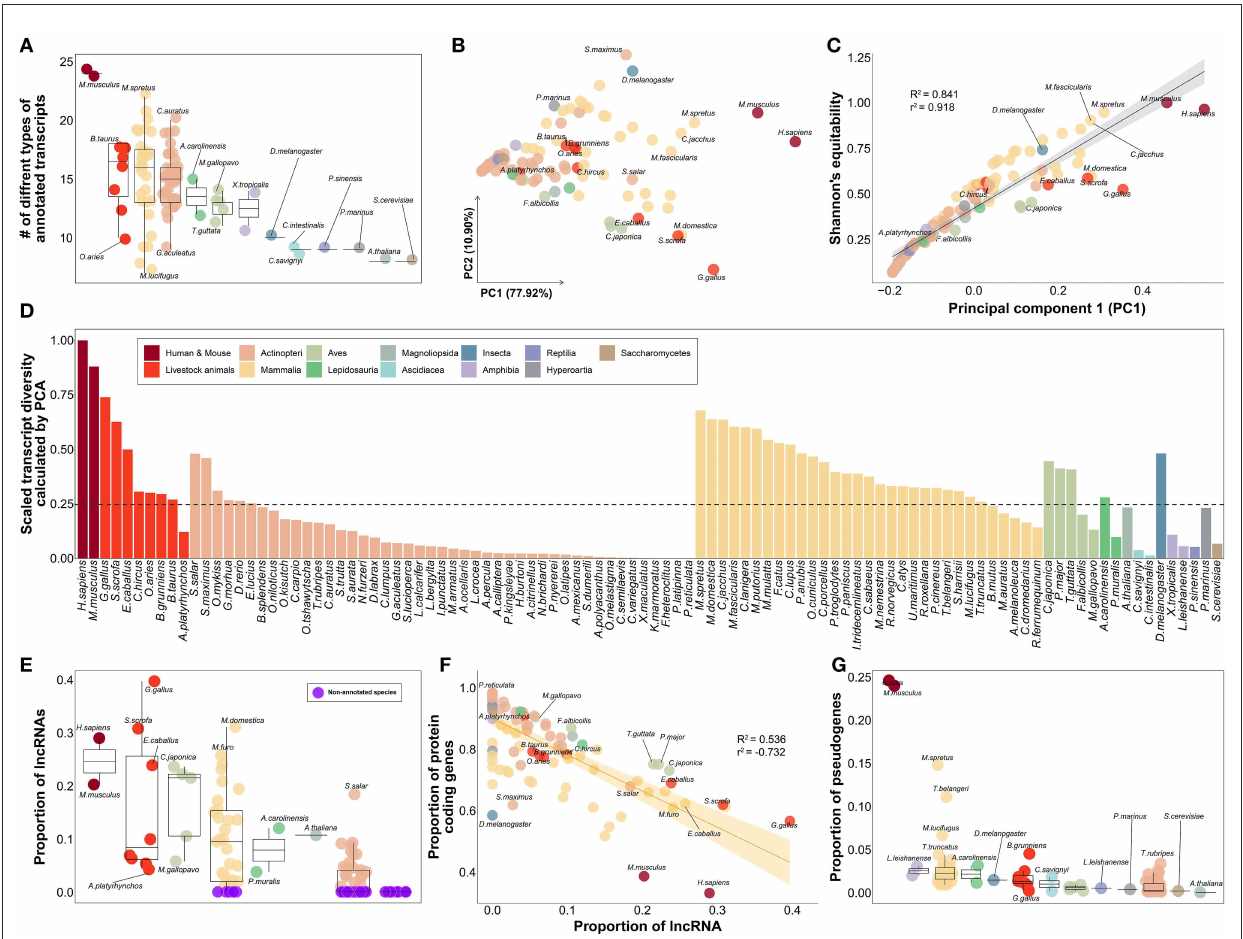
FIGURE4 Qualitative evaluation of gene annotation based on transcript diversity. (A) Comparison of the number of types found in each species out of a total of 30 transcript types annotated in gene annotations of 102 species. (B) Dimensional reduction results for the ratio of 30 transcript types in gene annotation of each species through principal component analysis. About 77.92% of the total variance in the original data was explained by the first principal component. (C) Results of correlation investigation between two methods of estimating transcript diversity: Shannon’s equitability and PC1 obtained through PCA. R 2 and r 2 represents coefficient of determination and correlation coefficient, respectively. (D) Comparison of transcript diversity index for all 102 species. (E) Comparison of the proportion of annotated lncRNAs in the gene annotations of each species. Purple indicates species with no lncRNA annotated at all. (F) Correlation between the proportion of lncRNAs and the proportion of protein-coding genes. R 2 and r 2 represents coefficient of determination and correlation coefficient, respectively. (G) Comparison of the proportion of annotated pseudogenes in the gene annotations of each species. (A–E) The colors in the figure share group information separated by class taxonomic level, except for human-mouse and eight livestock